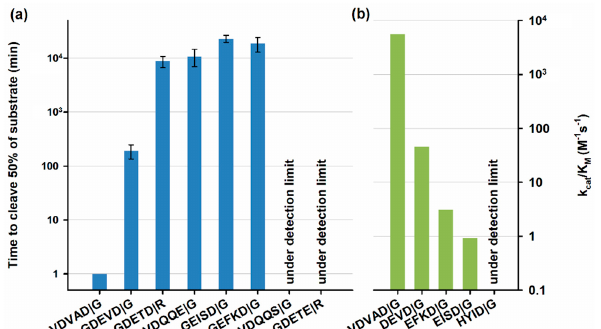
Figure 7. ( a ) specificity of cpCasp2 shown by cleavage of E2 substrate with varying recognition sites. Error bars are experimental standard deviation ( n = 3); ( b ) specificity of T7AC-cpCasp2 shown by cleavage of peptide substrates.